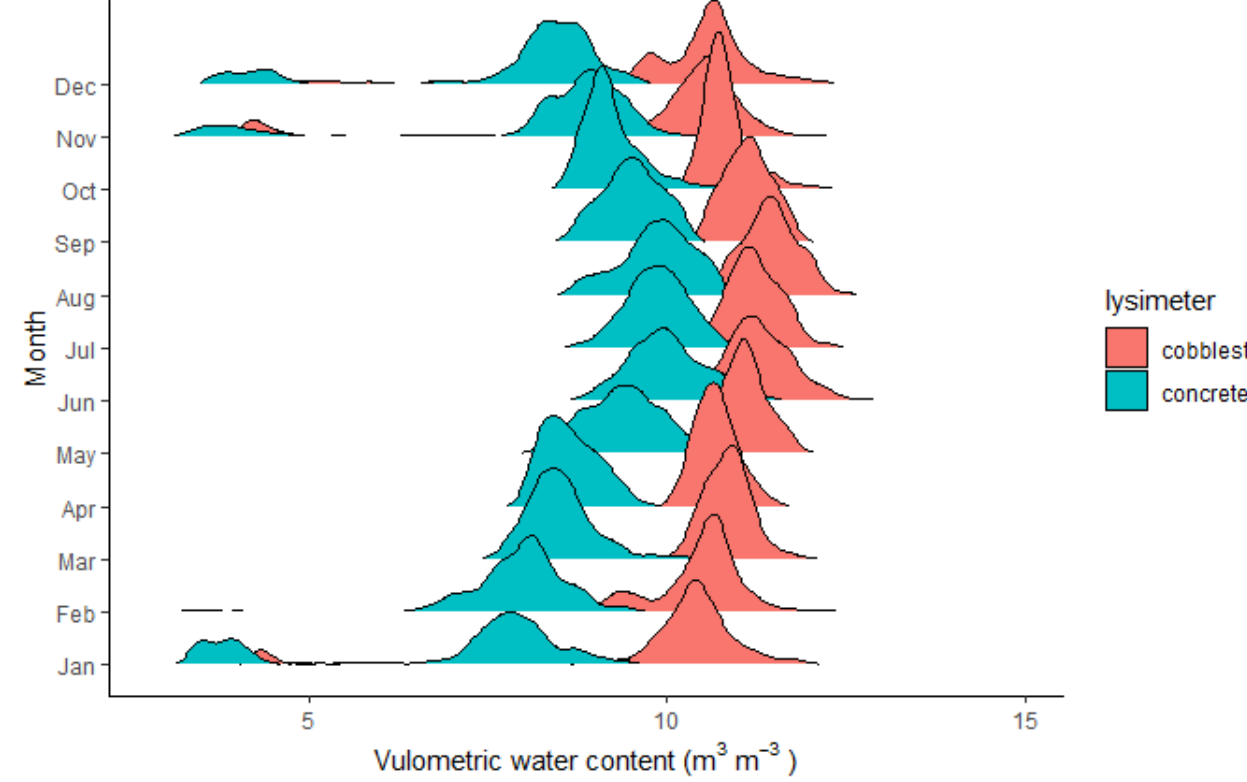
Figure 4. Distribution of soil moisture 5 cm beneath cobble stones and concrete slabs.